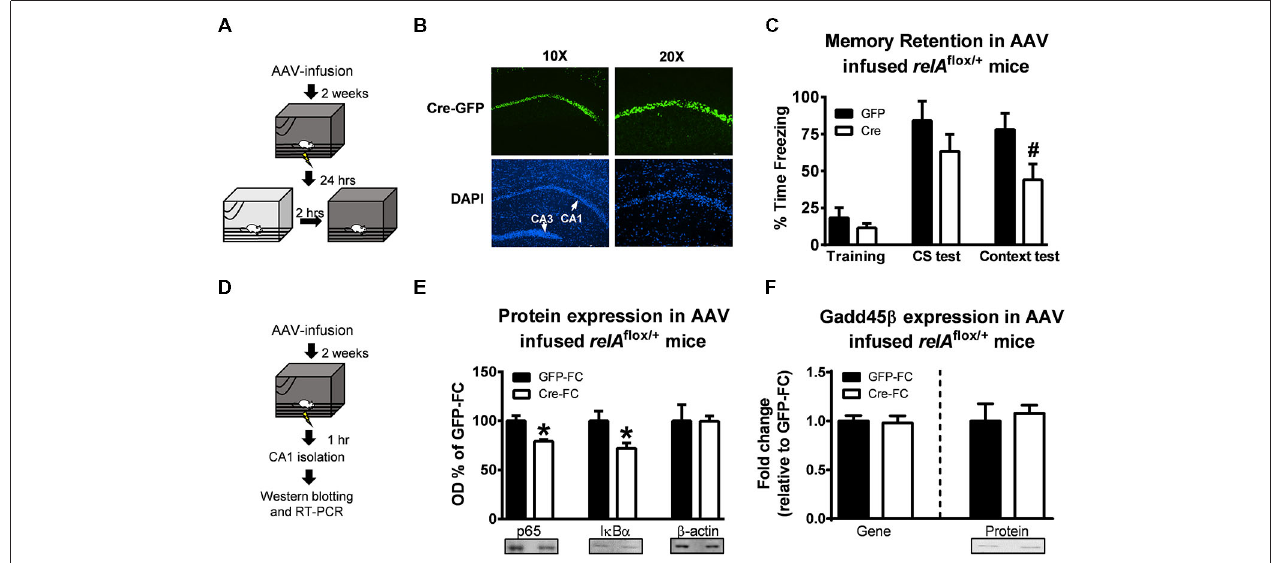
FIGURE 3 | Conditional mutation of p65/relA does not alter Gadd45 β expression in the hippocampus following learning. (A) Floxed p65/relA mice ( relA flox / + ) were injected with Cre-containing (AAV-CMV-Cre-GFP) or empty (AAV-CMV-GFP) adenoviruses 2 weeks prior to fear conditioning to induce mutation in the p65/relA gene. The day after training, mice were tested to the auditory cue followed by the context 2 h later. (B) Immunohistochemistry showing GFP expression in the hippocampus. DAPI was used to visualization the different hippocampus sub-regions. (C) While there were no differences between group during training or testing to the auditory cue, relA flox / + mice receiving Cre injections had impaired contextual fear memory relative to controls ( n = 5–7 per group). (D) relA flox / + were injected with Cre-containing (AAV-CMV-Cre-GFP) or empty (AAV-CMV-GFP) adenoviruses 2 weeks prior to fear conditioning and area CA1 collected 1 h later. (E) Western blot analysis confirmed knockdown of p65 and I κ B α expression in the Cre-infused mice ( n = 4–5 per group). (F) There were no differences in Gadd45 β gene or protein expression following Cre-infusion relative to GFP-infused controls ( n = 4–5 per group). ∗ p < 0.05 from GFP. # p = 0.054 from